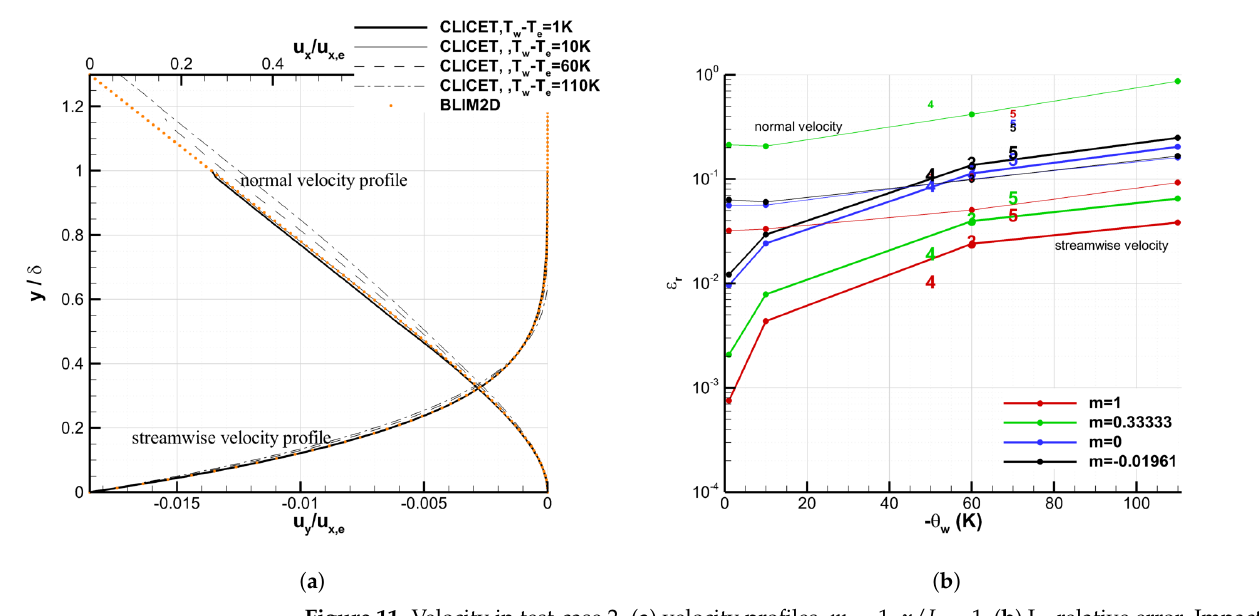
Figure 11. Velocity in test-case 2. ( a ) velocity profiles, m = 1, x / L = 1, ( b ) L 2 relative error. Impact of the wall temperature changes on the profiles. The errors of test cases 3, 4 and 5 are super-imposed (large case size: u x ; small case size: u y ). N x =